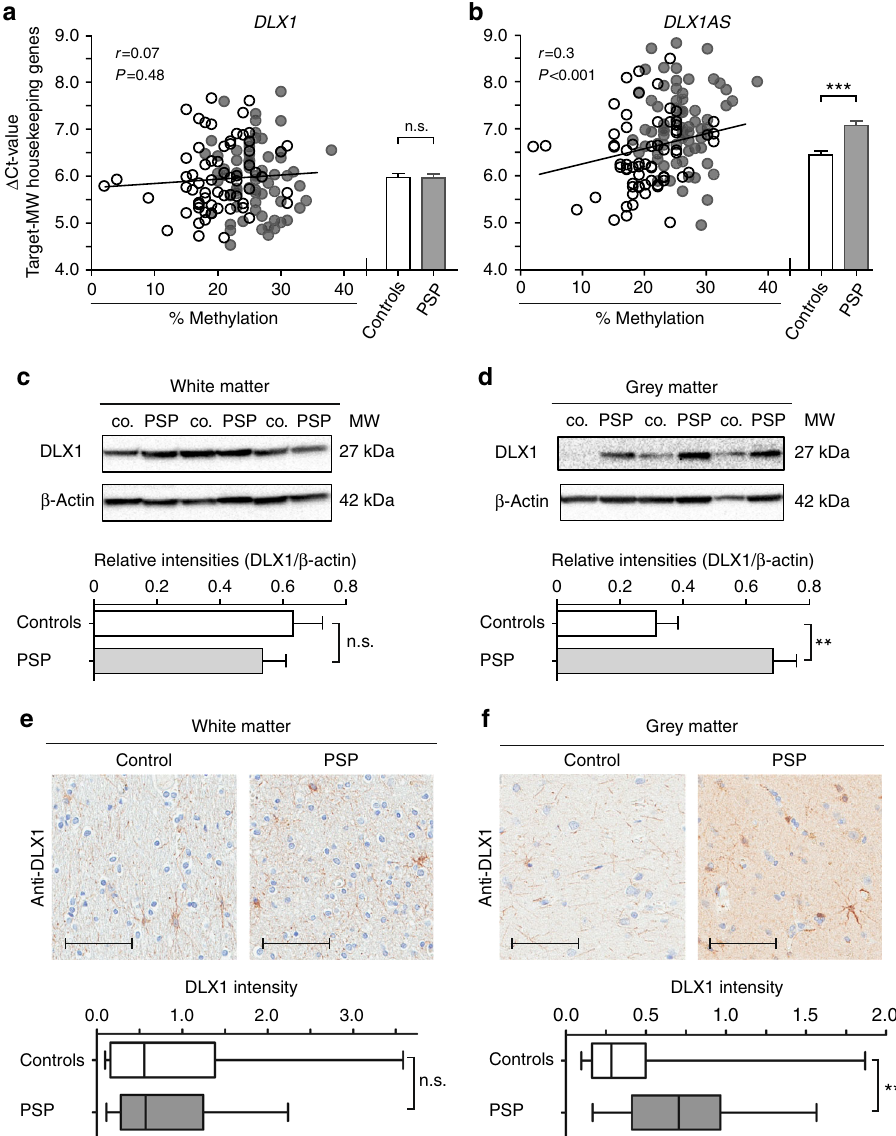
Fig. 4 DLX1 expression. a No correlation between expression of DLX1 and degree of methylation in human forebrains (pyrosequencing value at CpG [hg19] chr2:172,953,097) [Pearson ’ s correlation analysis including both PSP patients ( n = 69, gray dots) and controls ( n = 67, white dots)]. Expression of DLX1 did not differ between patients and controls (Welch´s corrected unpaired t -test, n.s. = not signi fi cant, bar plot with mean and SEM). b Signi fi cant correlation between expression of DLX1AS and the degree of methylation. Expression of DLX1AS is signi fi cantly reduced in patients as compared to controls (*** P < 0.001, Welch´s corrected unpaired t -test, bar plot with mean and SEM). c , d No difference between the amount of DLX1 protein in white matter of frontal lobe of PSP patients and controls (co.). c Signi fi cant increase of DLX1 protein in frontal lobe gray matter of PSP as compared to controls. d ( n = 8 per group, ** P < 0.01, Welch´s corrected unpaired t -test, bar plot with mean and SEM). β -Actin was used as loading control. e No difference in immunoreactivity of DLX1 in white matter of gyrus frontalis between PSP and controls. f Signi fi cant increase of DLX1 protein in frontal lobe gray matter of PSP patients as compared to controls ( n = 24 PSP, n = 9 controls, ** P < 0.01, Mann – Whitney Test). Scale bar: 100 µ m. The line in the middle of the box and whisker graph represents the median (50th percentile). The box extends from the 25th to 75th percentile. The whiskers extend from the lowest to